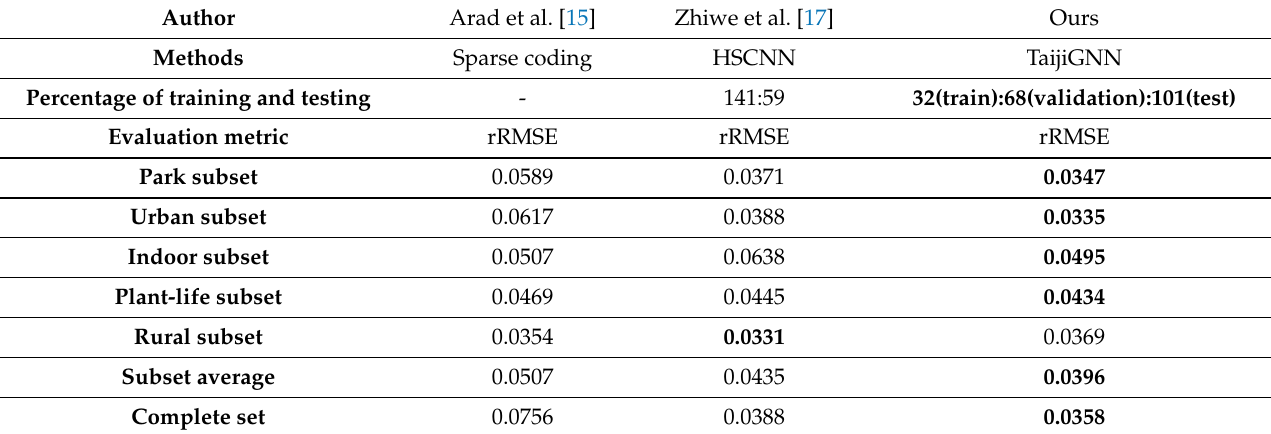
Table 8. The three approach results of reconstructing MSIs from RGBs on the ICVL